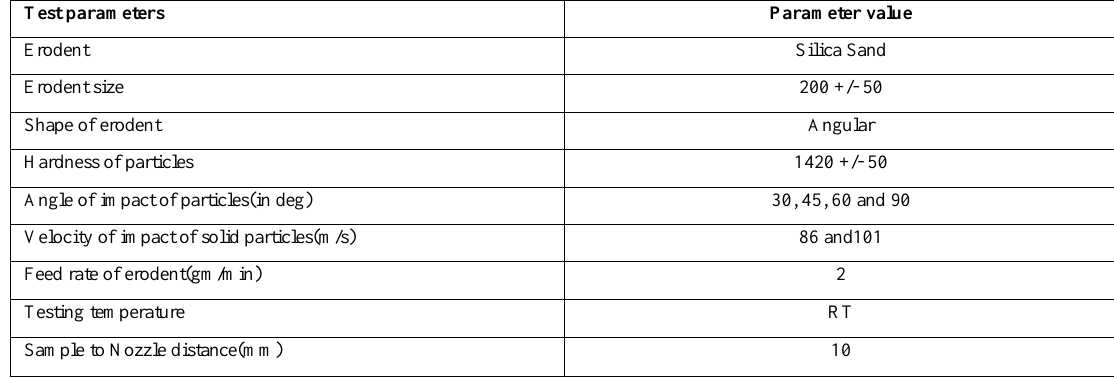
Table 2. Testing conditions for erosion